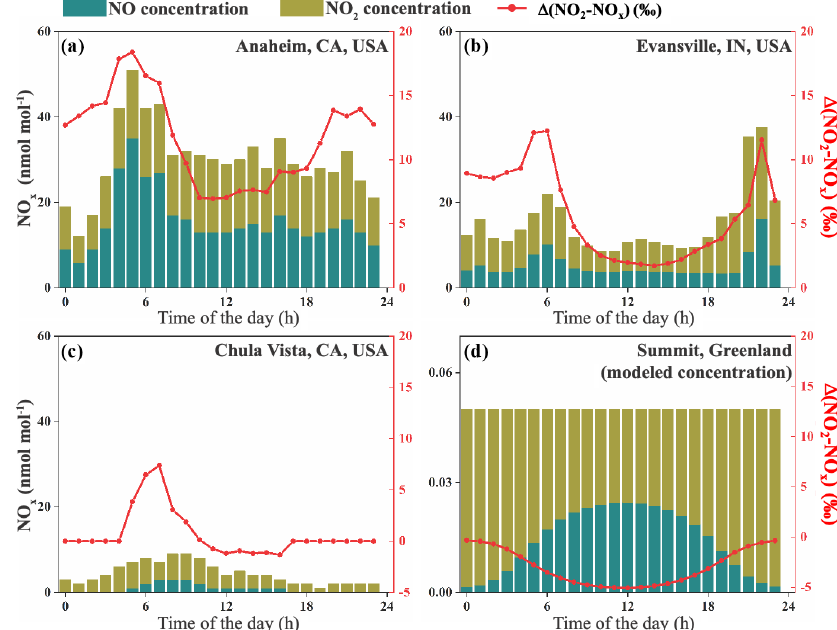
Figure 3. NO x concentrations and calculated (cid:49) (NO 2 –NO x ) values at four sites. Stacked bars show the NO and NO 2 concentrations extracted from monitoring sites (a–c) or calculated using a 0-D box model (d) ; the red lines are (cid:49) (NO 2 –NO x ) values at each site. Note that the NO x concentration (left y axis in panel d ) is different from the